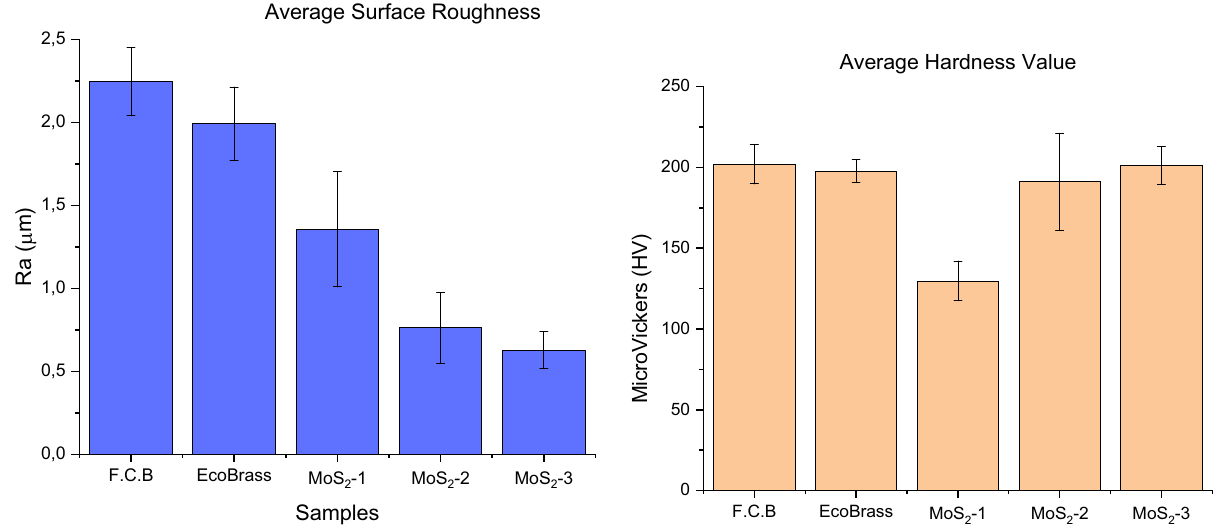
Figure 10: Average surface roughness values of the samples. Figure 11: Average hardness values of the